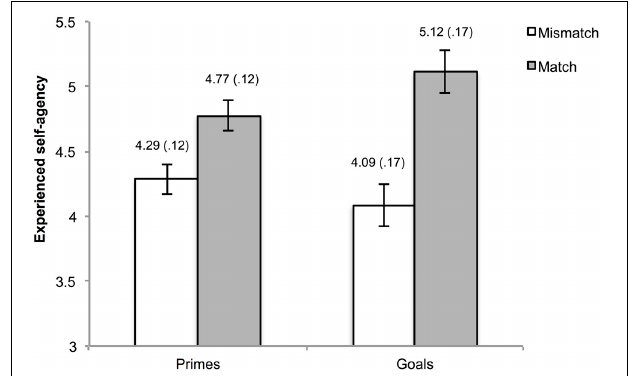
FIGURE 2 | Reported experience of agency as a function of type of pre-activation and matching. The numbers above the bars represent the mean and standard error (also reflected by the error bars) of the corresponding